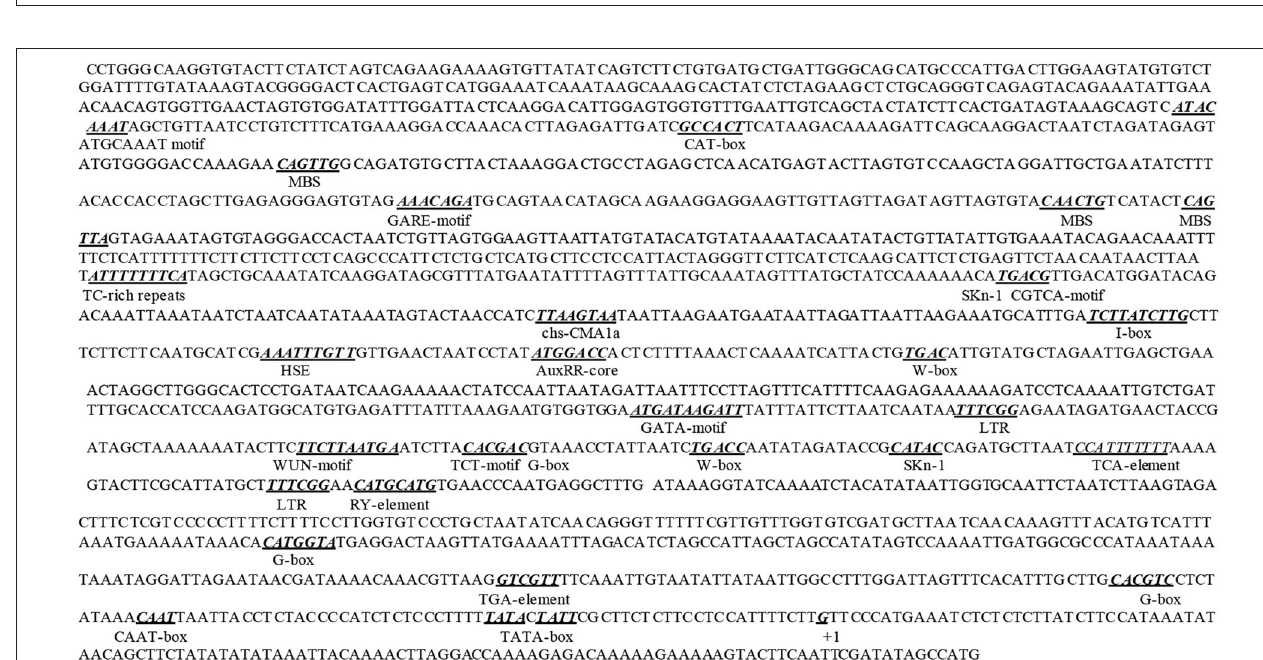
FIGURE 5 | The bioinformatics analysis of NtWRKY-R1 promoter. TC-rich repeats: Nicotiana tabacum cis-acting element involved in defense and stress response; TGA-element: Brassica oleracea auxin-responsive element ( − 132 ∼ − 137); TCA-element: Nicotiana tabacum cis-acting element involved in salicylic acid response; LTR: Hordeum vulgare cis-acting element involved in low-temperature response; AuxRR-core: Nicotiana tabacum cis-acting regulatory element involved in auxin response ( − 855 ∼ − 862); CGTCA-motif: Hordeum vulgare cis-acting regulatory element involved in the MeJA-response ( − 1,025 ∼ − 1,030); GARE-motif, Brassica oleracea gibberellin-responsive element; ATGCAAAT motif, cis-acting regulatory element associated to the TGAGTCA motif; HSE, cis-acting element involved in heat stress response; G-box, I-box, TCT-motif, chs-CMA part of a light responsive element; MBS, MYB binding site involved in drought-inducibility; SKn-1, cis-acting regulatory element required for endosperm expression; CAT-box, cis-acting regulatory element related to meristem expression; RY-element, cis-acting regulatory element involved in seed-specific regulation; WUN-motif, wound-responsive element.